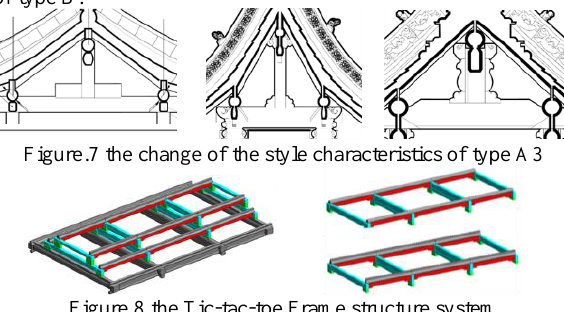
Figure.8 the Tic-tac-toe Frame structure system Table.6 style characteristics combinations staging results Staging